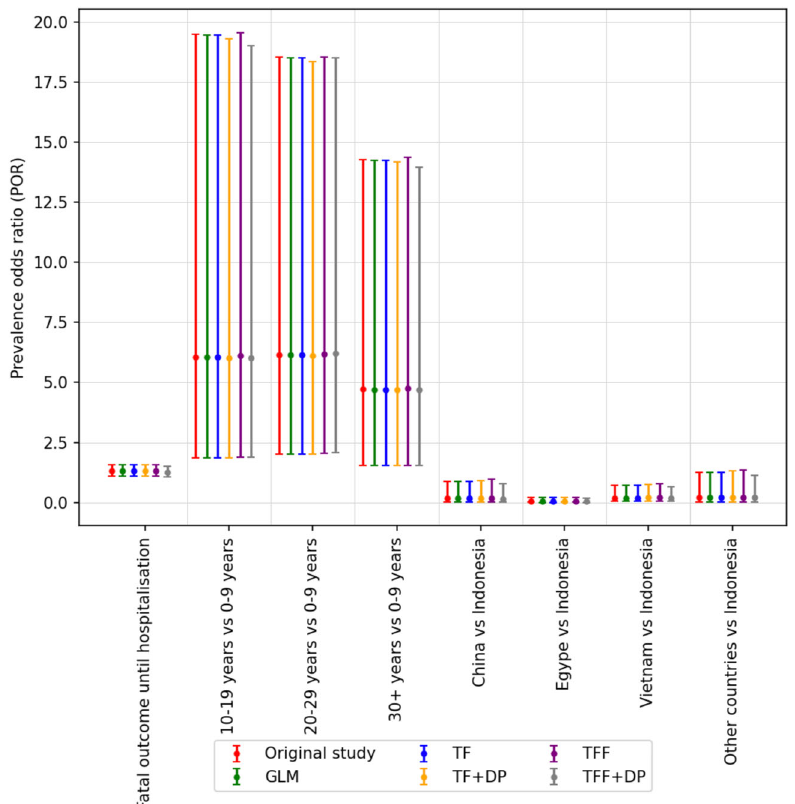
Fig. 3 The odds ratio other than red color are generated using our models. The odds ratio generated by our models are consistent with the odds ratio of the original study. The vertical bar along with each coef fi cient shows 95% con fi dence level of corresponding